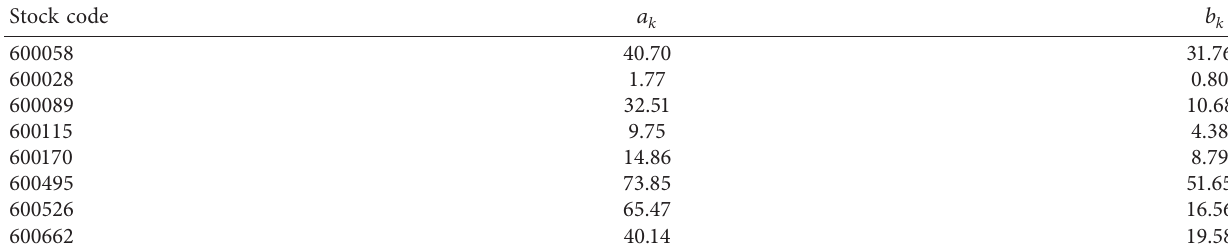
Table 2: The possibility distribution of turnover rates